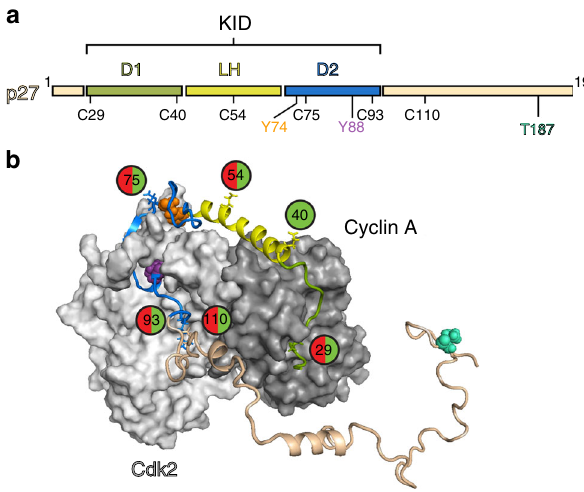
Fig. 1 Domain structure of p27. a Full-length p27 contains the kinase inhibitory domain (KID), which is subdivided into domain 1 (D1), linker helix (LH), and domain 2 (D2). Tyrosine phosphorylation sites are labeled as Y74 and Y88 and the threonine phosphorylation site is labeled as T187. The labeling positions of cysteine residues are indicated as C29, C40, C54, C75, C93, and C110. b The structure of p27 in complex with Cdk2/cyclin A based on pdb:1JSU 12 and molecular dynamics simulations 17 . Labeled sites are represented as circles, green only for smFA experiments and green/red circles where used in both smFA and smFRET experiments. The p27 residues that are modi fi ed by kinases (Y74, Y88, and T187) are shown in orange, purple, and teal spheres,